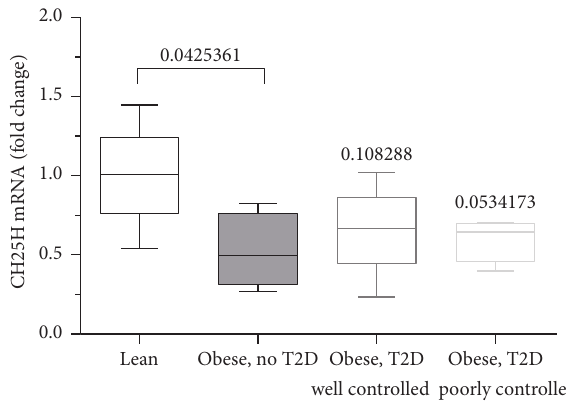
Figure 2: Dataset on liver CH25H mRNA levels in lean subjects and obese patients with and without type 2 diabetes. CH25H mRNA levels are decreased in obese patients without diabetes versus lean subjects. Levels of obese patients showing poorly controlled type 2 diabetes patients are decreased as well whereas 𝑝 values for mRNA levels of obese, well controlled type 2 diabetes patients are not significant. GDS3876/206932 at/CH25H. Obese patients with and without type 2 diabetes: liver. Homo sapiens